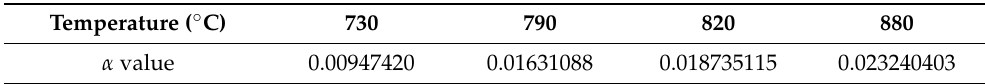
Table 2. Corresponding α values at different temperatures.